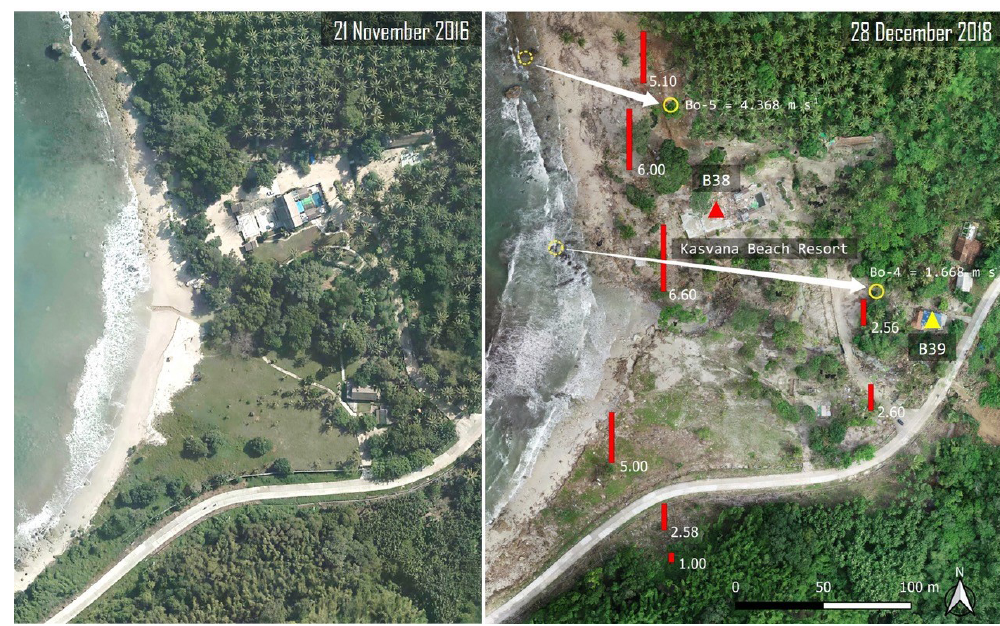
Figure 7. The land destruction and flow depth distribution at Cipenyu Beach, Banten. Panel (a) is an image captured before the tsunami (from Google Earth). Panel (b) is an aerial view captured by drone on 29 December 2018.